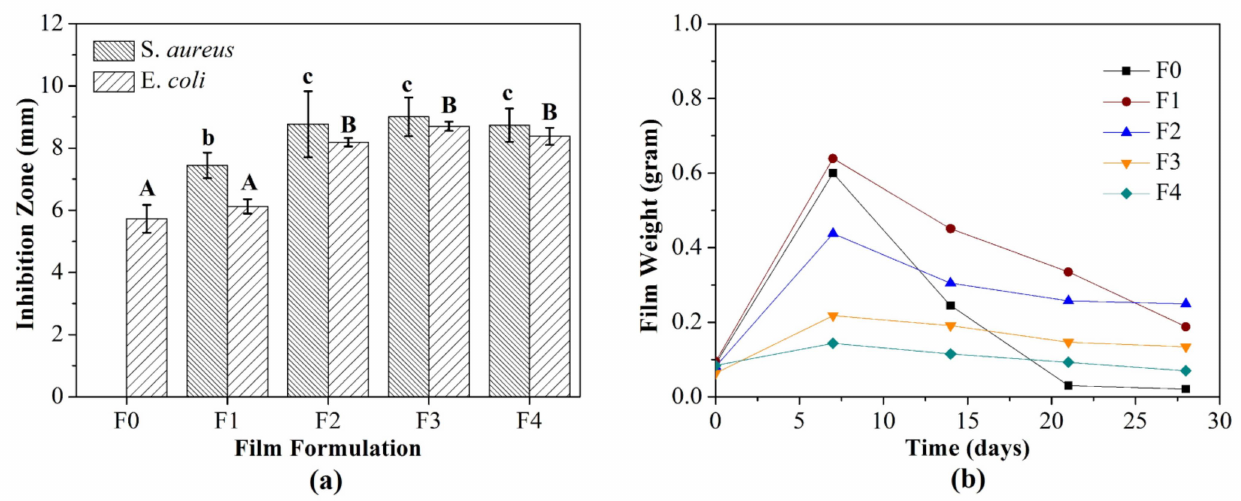
Figure 4. Antimicrobial activity ( a ) and biodegradation rate ( b ) of the bionanocomposite and control films. F0: SRiC film (control film), F1: SRiC film with SiO 2 -ZnO nanoparticles, F2: SRiC/CS (1.5 wt%: 0.5 wt%) with SiO 2 -ZnO nanoparticles, F3: SRiC/CS (1.0 wt%: 1.0 wt%) with SiO 2 -ZnO nanoparticles, F4: SRiC/CS (0.5 wt%: 1.5 wt%) with SiO 2 -ZnO nanoparticles; A,B: uppercase letters indicate significant differences among each film formula inhibited E. coli ; b,c: lowercase letters indicate significant differences among each film formula inhibited S. aureus